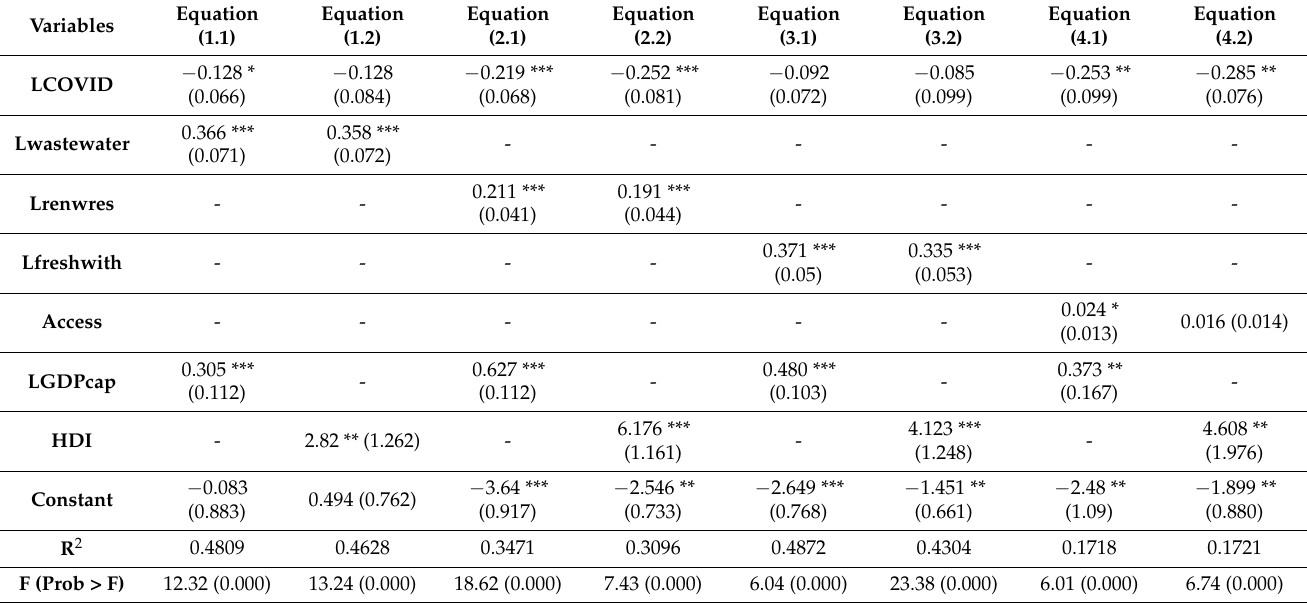
Table 7. Robust regression results—with control